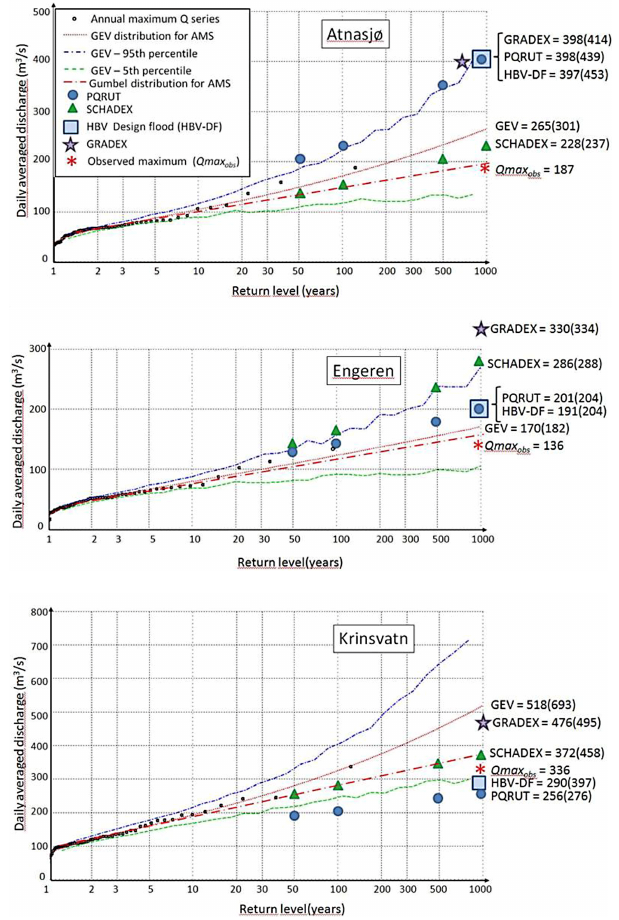
Figure 11. Comparison of estimates for the Q1000 discharges given by the various precipitation-runoff methods with statistical flood frequency analysis based on the annual maximum series.